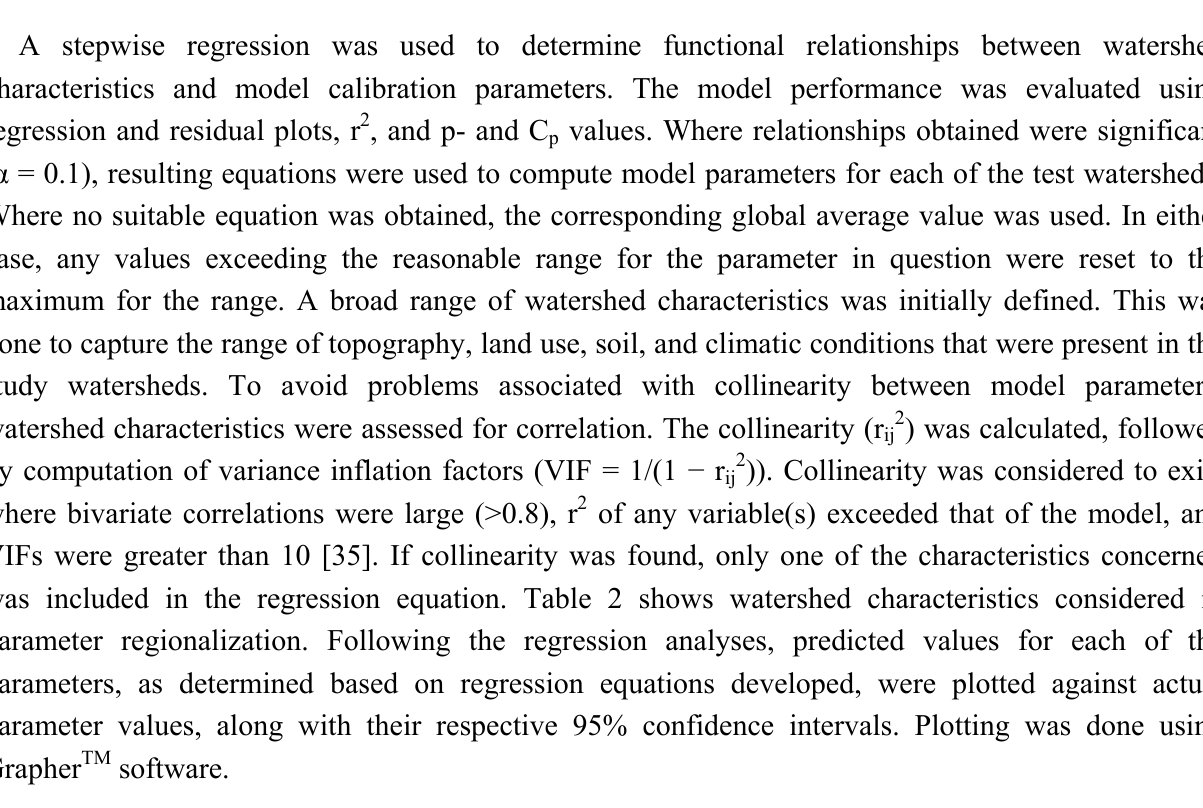
Table 2. Watershed characteristics considered in parameter